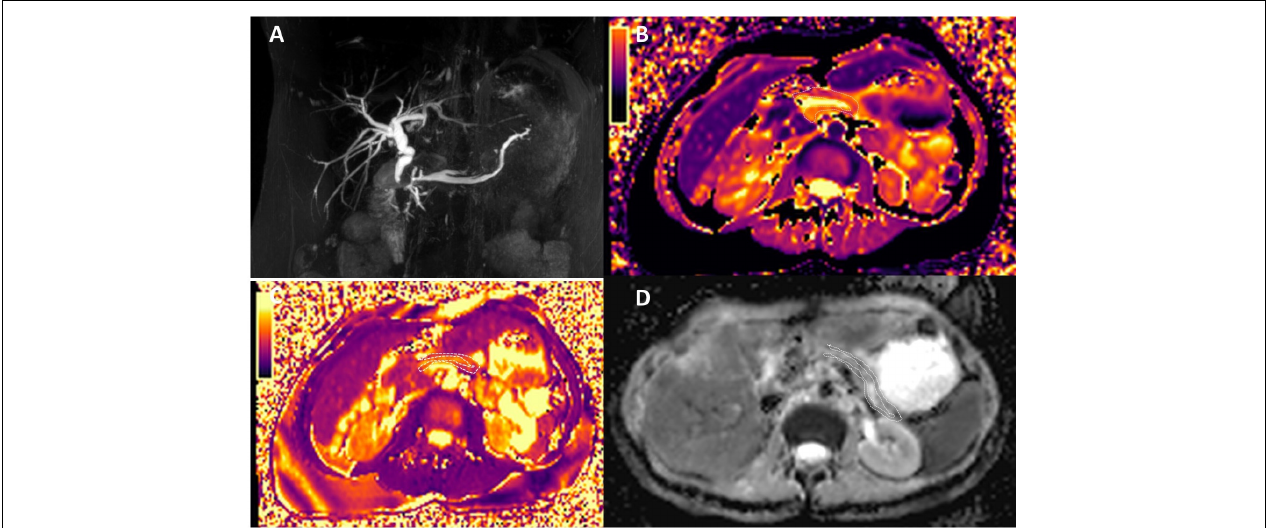
FIGURE 3 | Magnetic resonance cholangiopancreatography (A) , T1 mapping (B) , T2 mapping (C) , and ADC maps (D) of chronic pancreatitis (CP). The patient had the history of CP, and the amylase in the blood elevated. MRCP shows dilatation of the major pancreatic duct (MPD) and the branch pancreatic duct; the width of MPD was 4.5 mm. The T1, T2, and ADC of CP were 1,320 ± 220.9 ms, 57.0 ± 9.6 ms, and 1.320 ± 0.162 mm 2 /s, respectively.